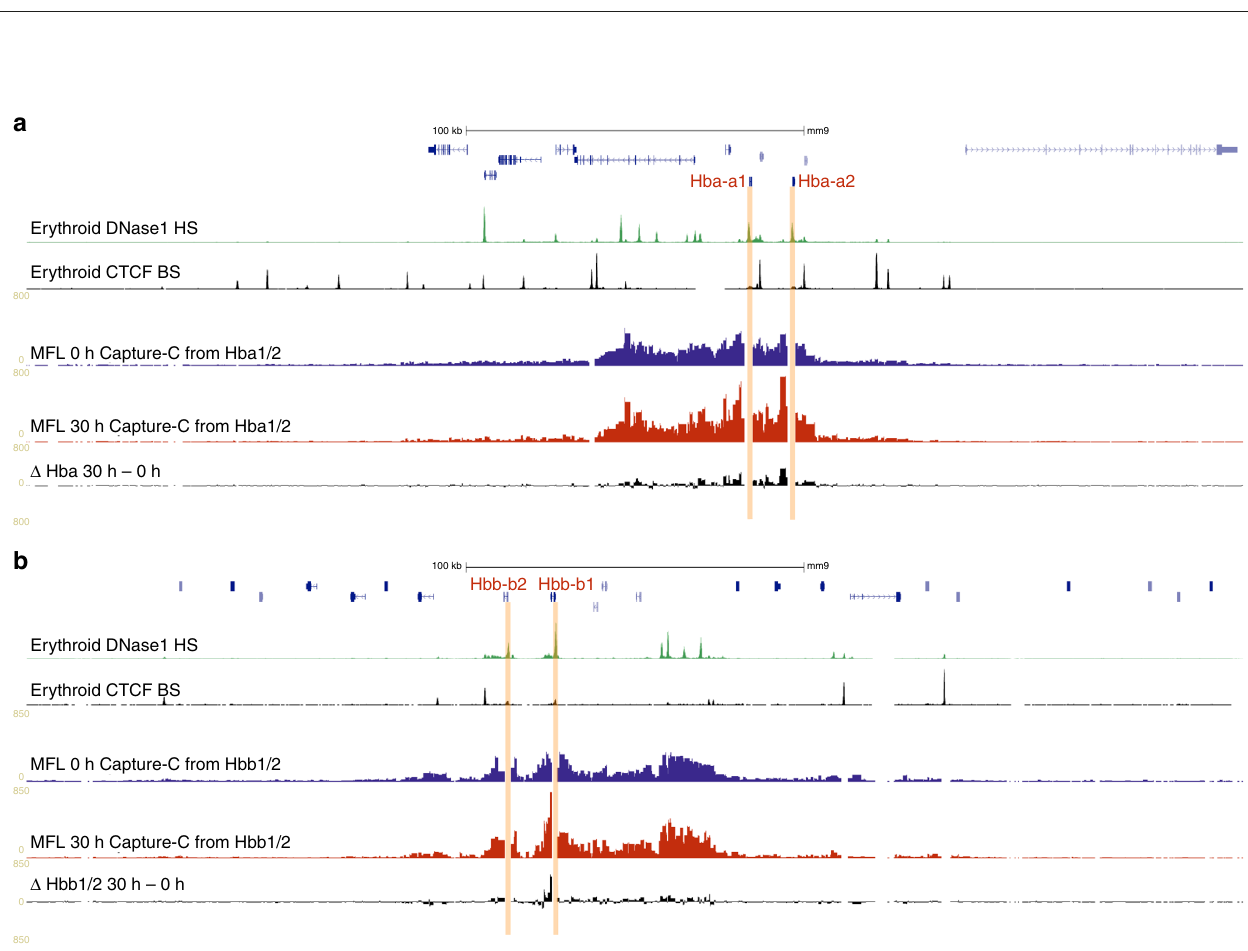
Fig. 1 Description of the mouse foetal liver-derived erythroblast populations and of the active murine α -globin locus. a Representative FACS plots of MFL erythroblasts de fi ned by CD44/cell size and Ter119, at 0 h and after a further 30 h differentiation in vitro, identifying distinct populations at the two timepoints. Bottom images are representative cell pellets at the two timepoints demonstrating the presence of haemoglobin at MFL 30 h. b Representative cytospins of the MFL 0 h and 30 h cultures. Scale bar 5 μ m. c Nascent Hba transcription relative to 18s in the cell types and MFL timepoints indicated, from 3 biological replicates. Error bar is standard deviation. d RNA-FISH analysis of nascent transcription from the α -globin and β -globin genes at MFL 0 h and 30 h. n = 388 at MFL0h and 416 at MFL30h. e Map of the gene dense murine α -globin locus with Hba genes highlighted in red and positions of the FISH probes used in brown and lime green (BAC probes) and red and blue (plasmid probes). Gene browser tracks depict DNase1 hypersensitive sites (HS green), CTCF-binding sites (BS black), H3K4me3 (brown) and H3K4me1 (blue). NG Capture-C derived interaction frequencies are shown in mES cells from the Hba1/2 viewpoints (grey), and in MFL 30 h from viewpoints (CTCF BS -39.5 (black), MCS-R1 (red), Hba1/2 (red) and CTCF BS + 48 (black). The location of the Hba genes, the fi ve murine enhancer elements and the CTCF BS − 39.5 and + 48 are marked against the browser tracks in yellow, grey and blue vertical bars,